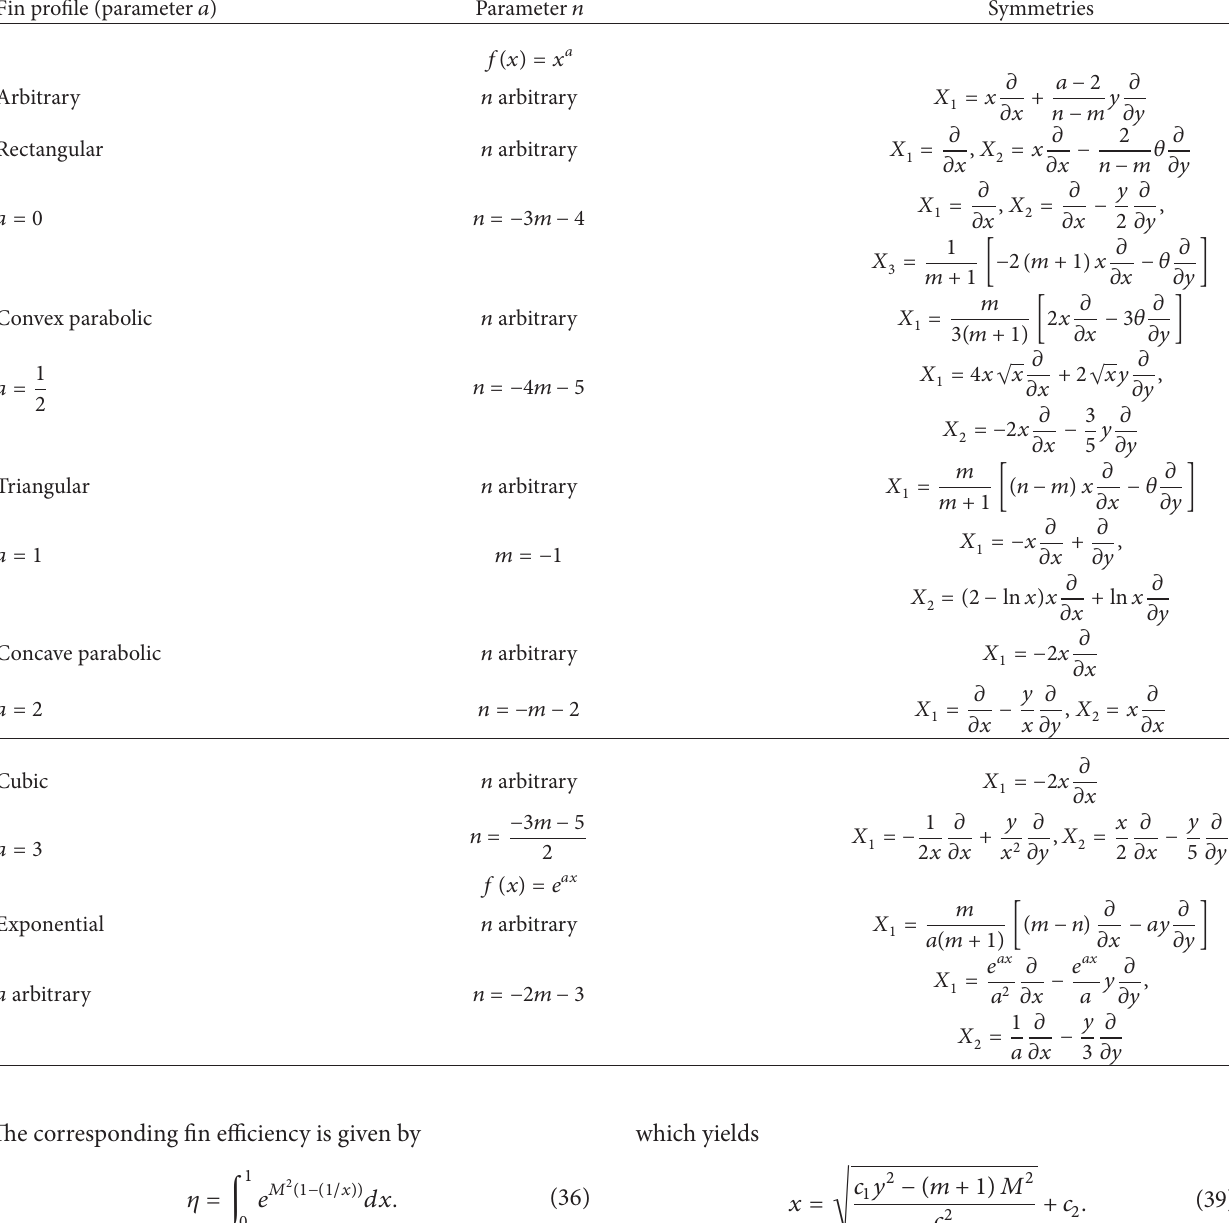
Table 8: Symmetries for 𝑚 ̸=𝑛, 𝑛 ̸= − 1 and various 𝑓(𝑥)